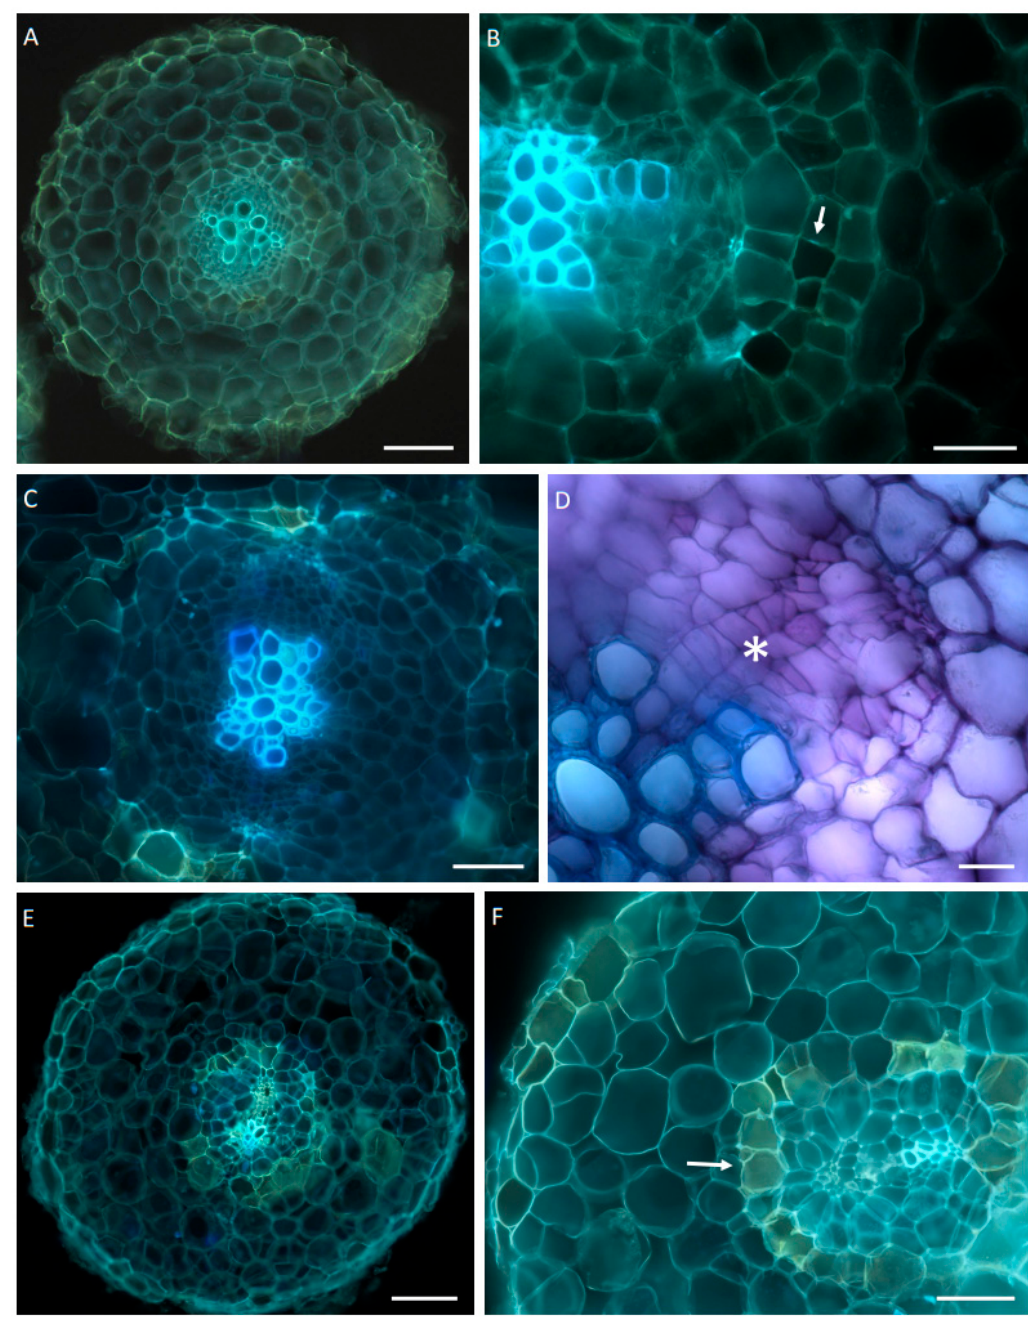
Figure 3. Anatomical structure of the roots—transverse sections. ( A – C , E , F )—autofluorescence, UVB; ( D )—bright field microscopy, staining with TBO. ( A ) The three-week-old root, primary structure. Note intact vascular cylinder and cortex. Scale bar—100 µ m. ( B ) Detail of vascular cylinder and endodermis with Casparian bands (arrow). No cambial initials are present. Scale bar—50 µ m. ( C ) The control root after 21 days of experiment with cambial initials and disrupted endodermis. Scale bar—50 µ m. ( D ) Detail of cambial initials (asterisk) above strands of primary xylem. Scale bar—20 µ m E. The jasmonic acid-treated root after 21 days of experiment. No visible signs of secondary growth. Scale bar—100 µ m. F. Detail of vascular cylinder and intact endodermis with lignified cell walls (arrow). Scale bar—50 µ m.